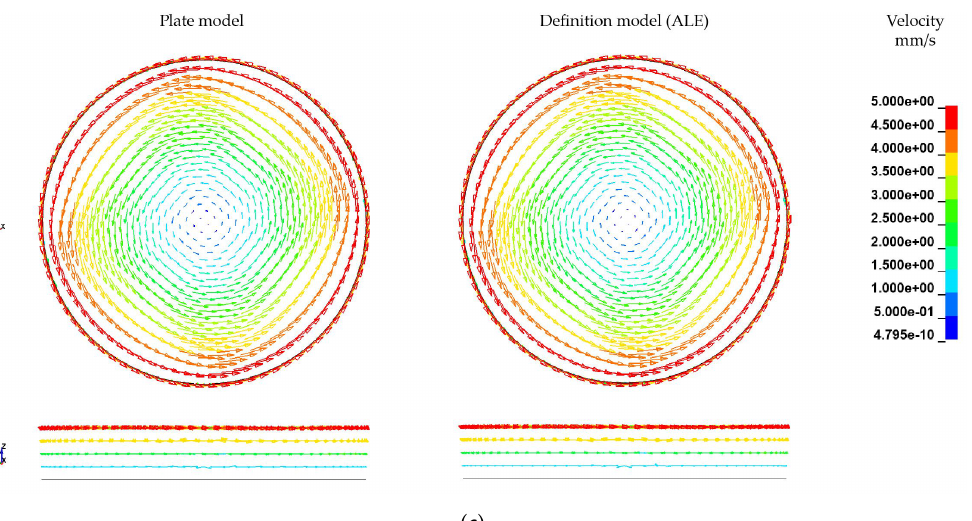
Figure 20. Comparison of velocity distribution at different timestamps without any scaling.